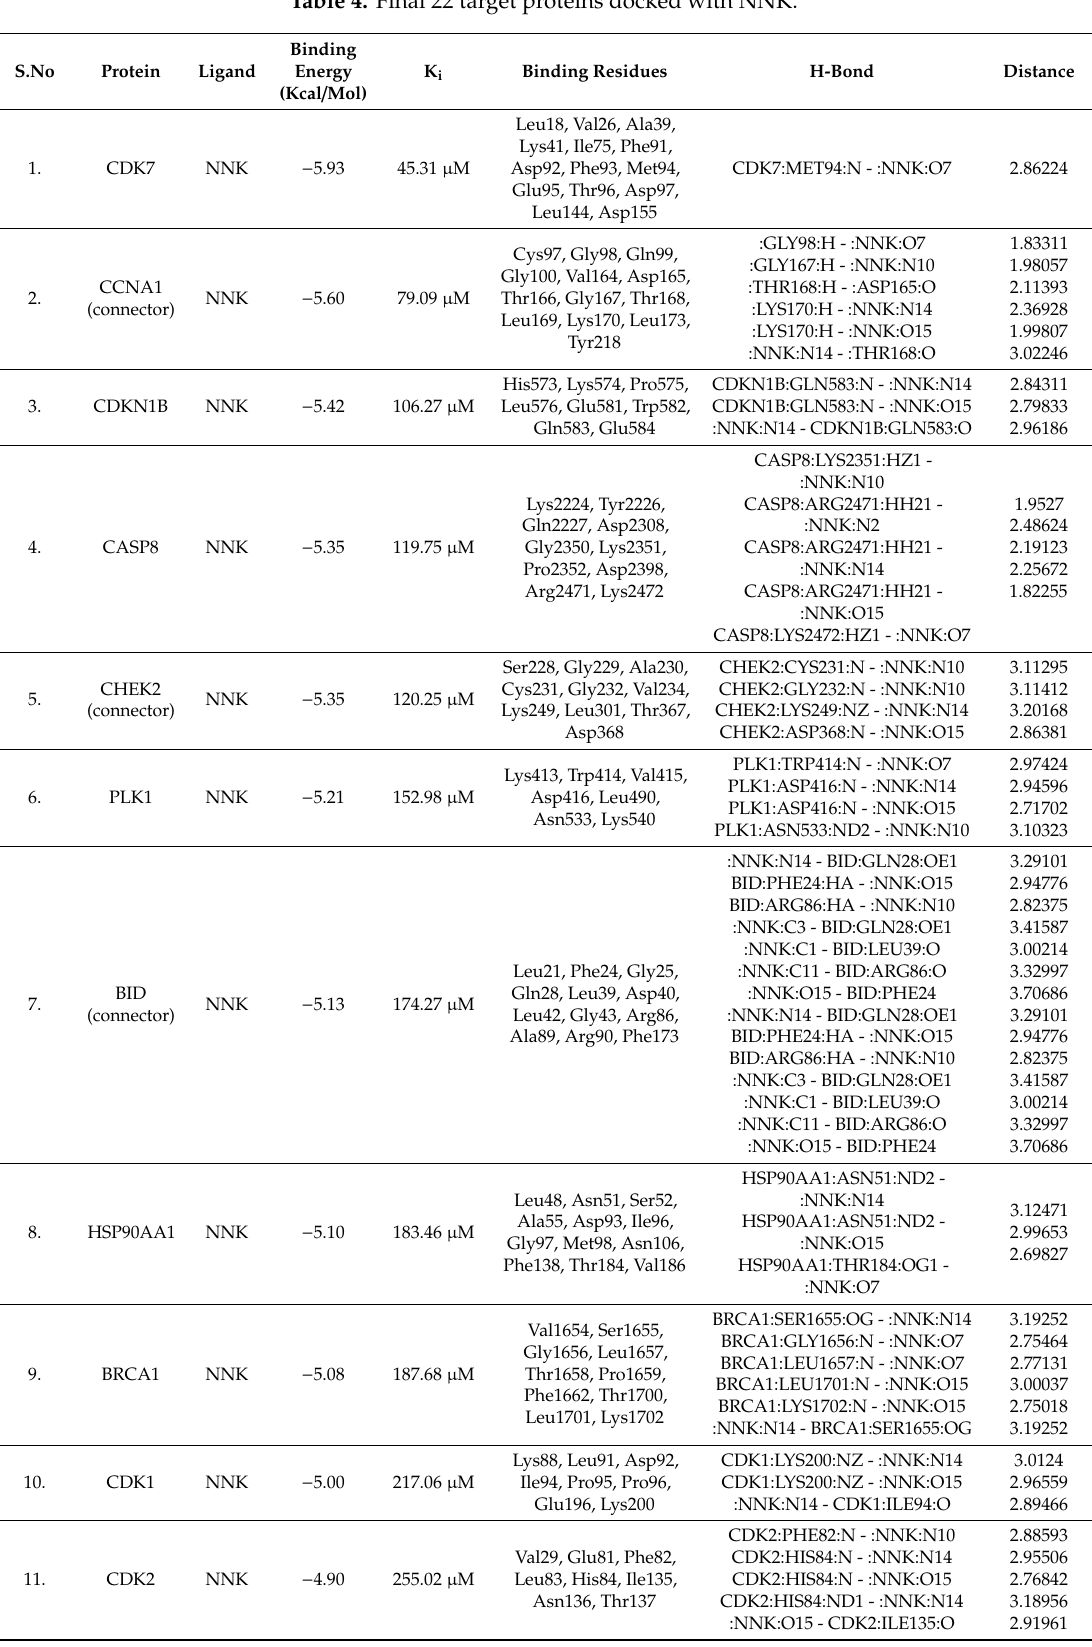
Table 4. Final 22 target proteins docked with